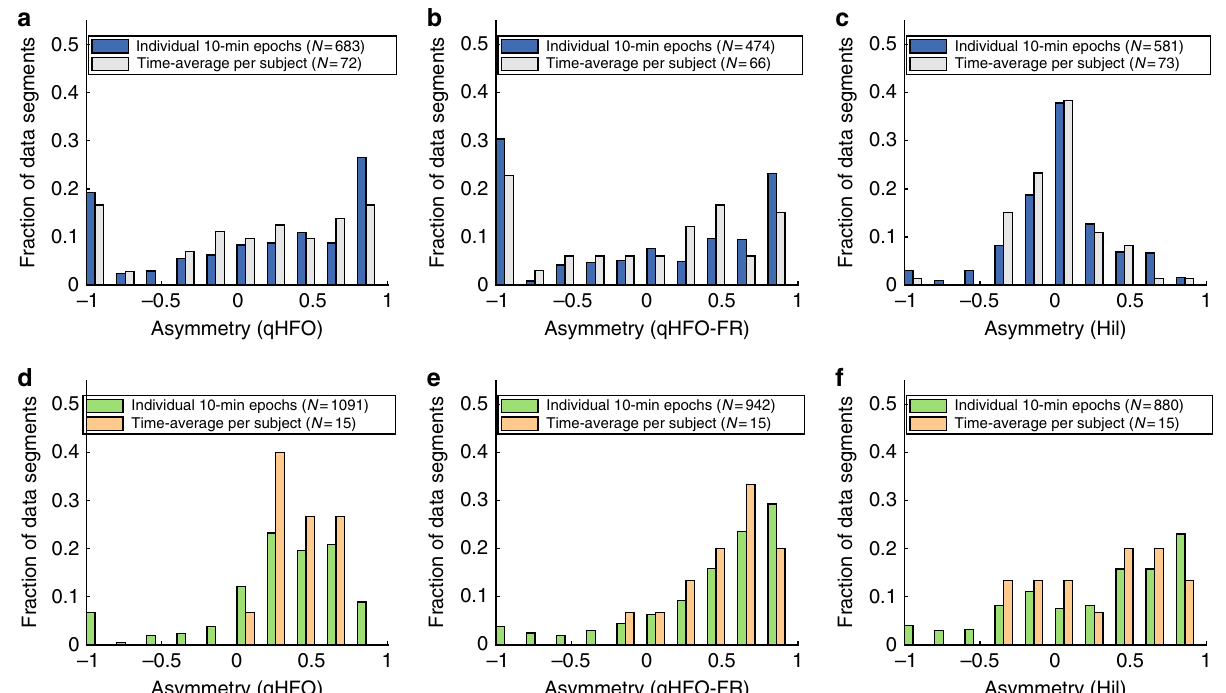
Fig. 2 Distribution of HFO rate asymmetries. Results are shown for both the Mayo cohort ( a – c ) and the UM NREM cohort ( d – f ), and for three different HFO detectors: qHFO ( a , d ), fast ripple enhanced qHFO (qHFO-FR) ( b, e ), and a Hilbert transform based detector ( c, f ). Asymmetry is the difference between average HFO rate inside versus outside the SOZ, divided by the sum. Asymmetries for HFO rates are displayed in histogram form for all available 10-min epochs in the cohort (blue, green) and averaged over all 10-min epochs in each individual patient (gray, orange). The asymmetry was only computed for cases with at least one channel having 0.5 HFOs/min. HFOs were determined to be related to SOZ if the median rate was signi fi cantly positive (right-tailed Wilcoxon Sign-Rank test, p < 0.05), seen as a skew to the right in the plots. HFOs from all three detectors in the UM cohort, and from the qHFO detector in the Mayo cohort, were associated with SOZ. There was no signi fi cant difference between using just 10 min of data or all data together in any cohort or for any detector (Wilcoxon Rank-Sum test, 0.1 < p < 0.9). Note, several patients had an asymmetry of − 1 when there were no HFOs in the SOZ and at least one channel having >0.5 HFOs per min outside the SOZ. This often occurs in data with low signal quality, and thus occurs much